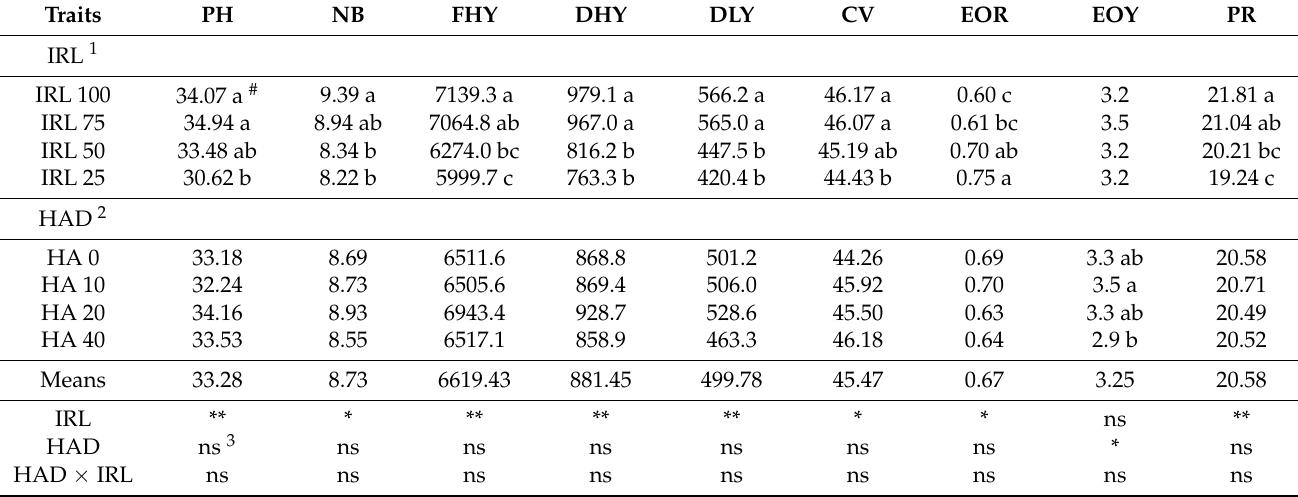
Table 2. Analysis of variance and mean values of the examined morpho-physiological characteristics of Ocimum basilicum L. cultivated under different IRL and HAD conditions (2017) without